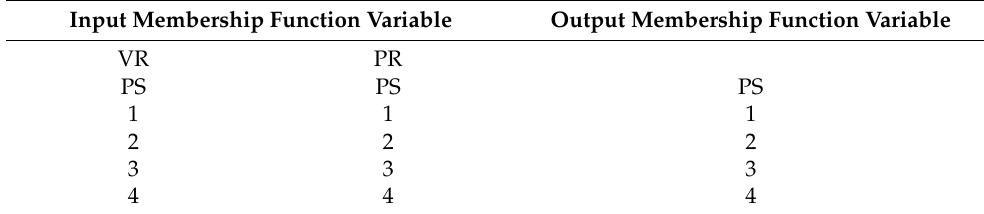
Table 2. Input and output membership function variable.